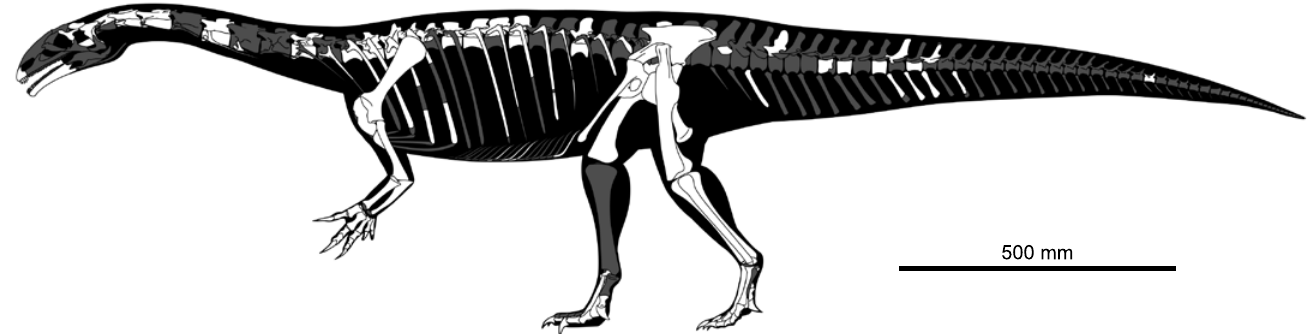
Fig. 14. Skeletal reconstruction of MSF 15.8B., preserved elements highlighted in white, grey elements restored following adult Plateosaurus skeletons SMNS 13200 (von Huene 1926) and GPIT 1 (Mallison 2010a,